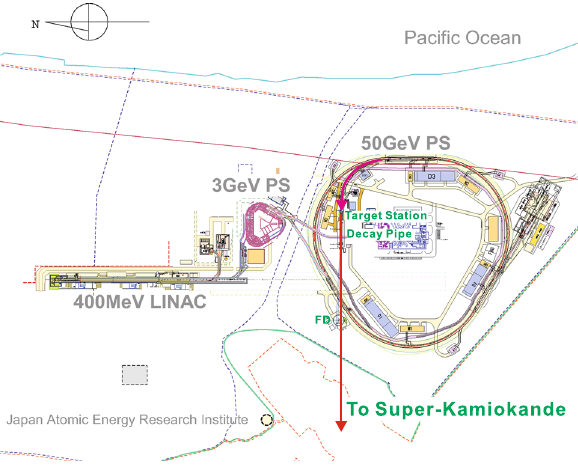
Fig. 45 The layout of J-PARC accelerator complex